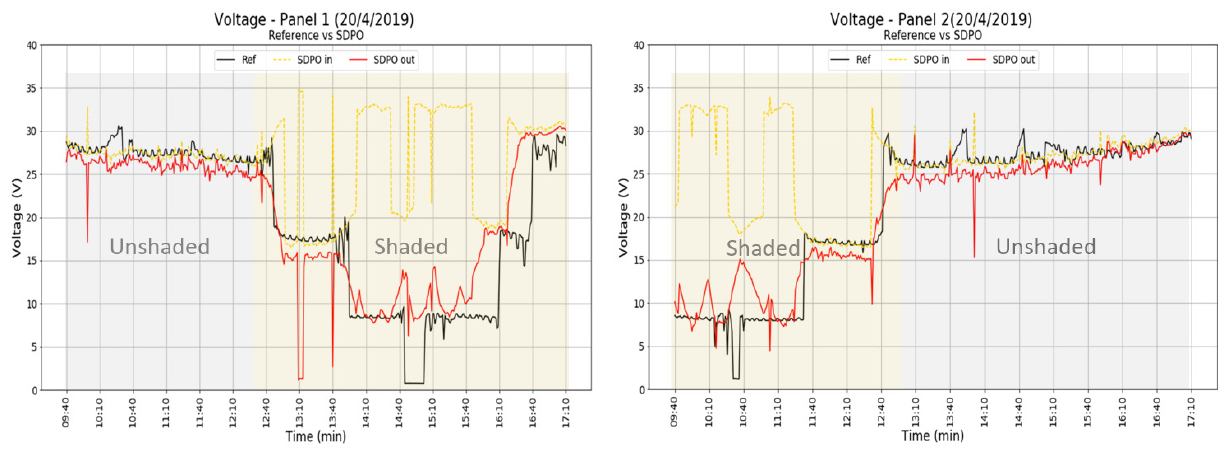
Figure 5. Voltage input and output of the optimized module versus the reference module, which is connected in a string of six modules.